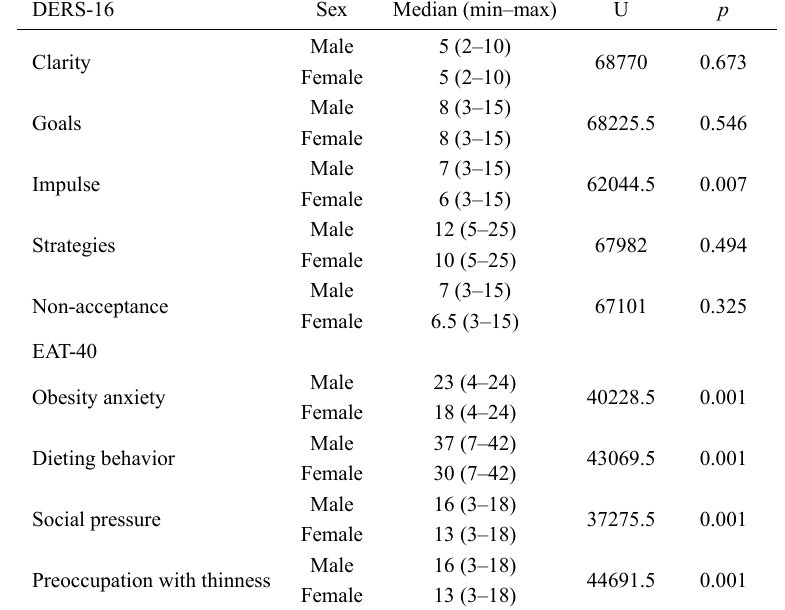
Table 3. Comparison of DERS-16 and EAT-40 subscale scores of university students by